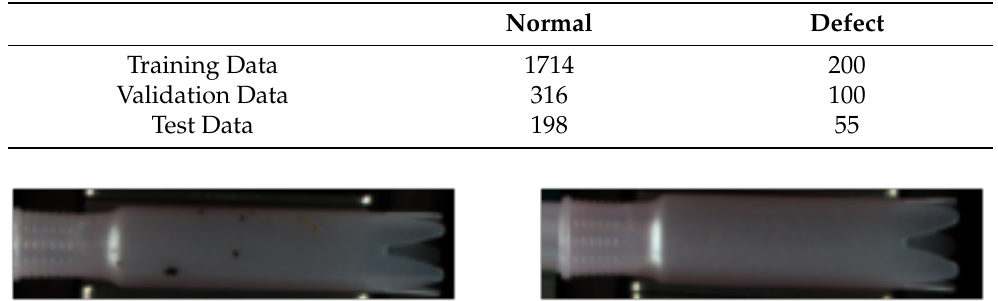
Figure 6. Sample Images of Product: Defect ( left ) and OK ( right